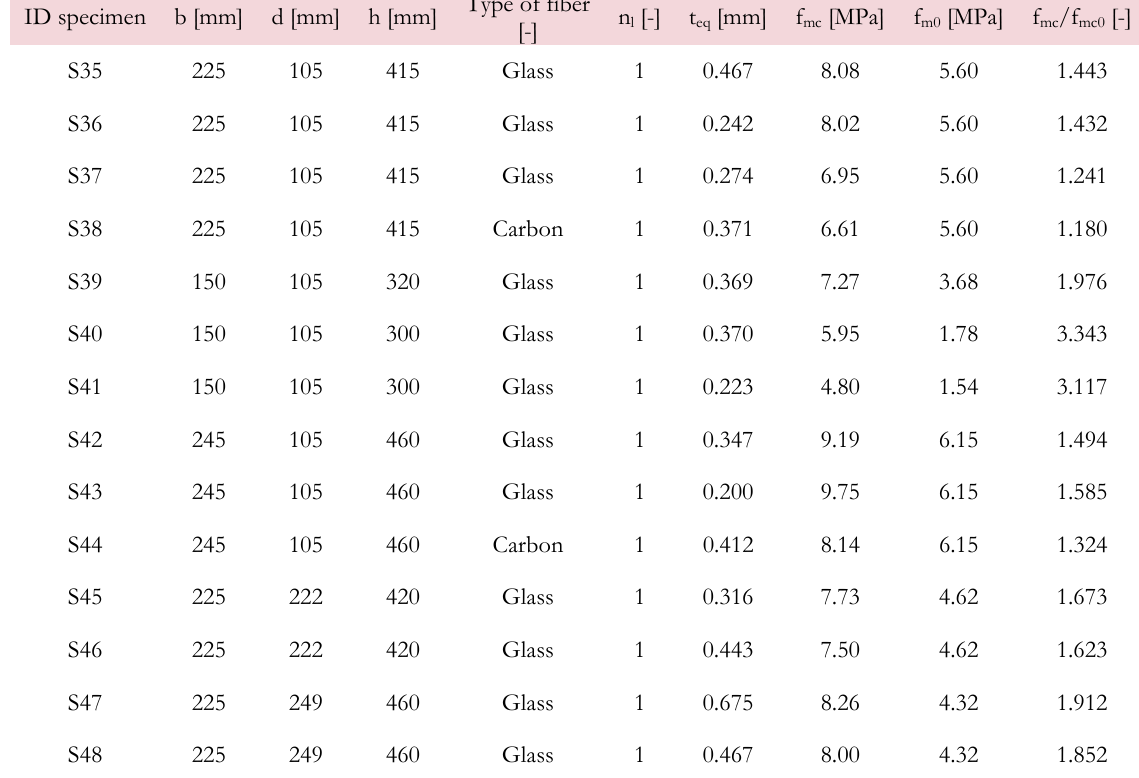
Table 9.B: Geometrical characteristics and experimental results